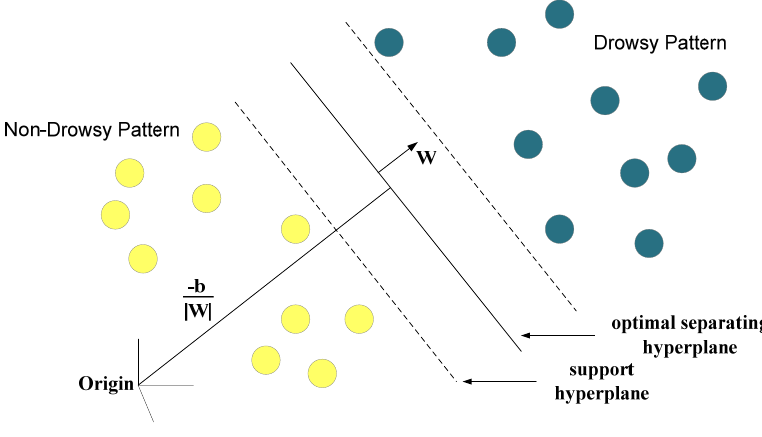
Figure 4. Illustration of SVM